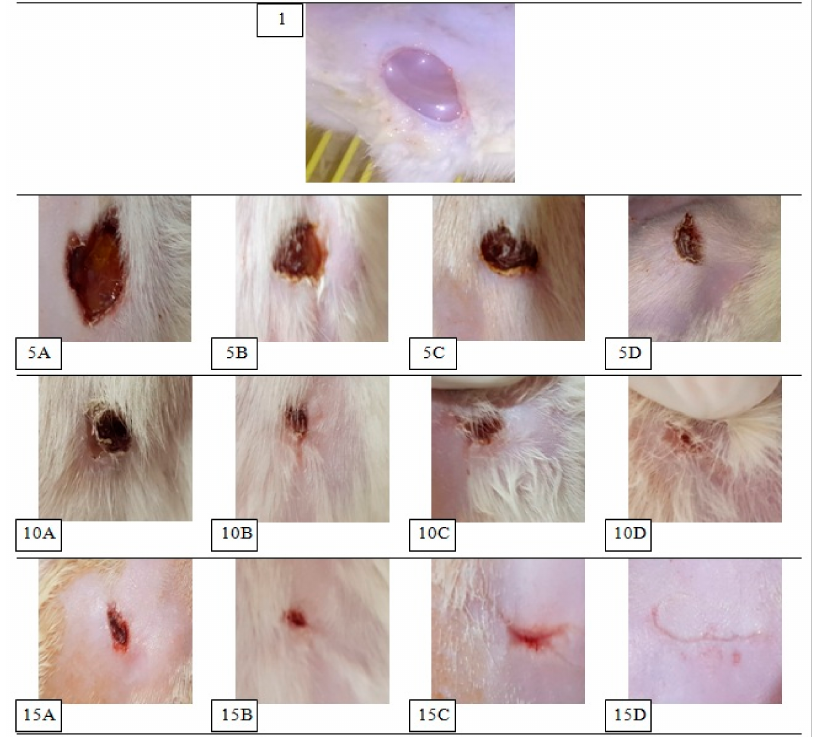
Figure 8. Photographs of the changes in the wound sizes at day 0, 5, 10 and 15, for the non-treated control group ( A ), treated group with NVH suspension ( B ), treated group with blank chitosomal formulation ( C ) and treated group with NVH-loaded chitosomal formulation F6 ( D